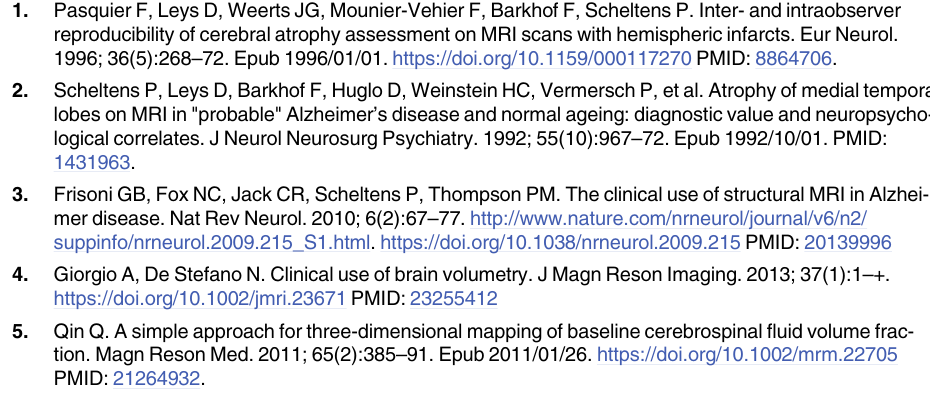
-basedbrain seg- 1